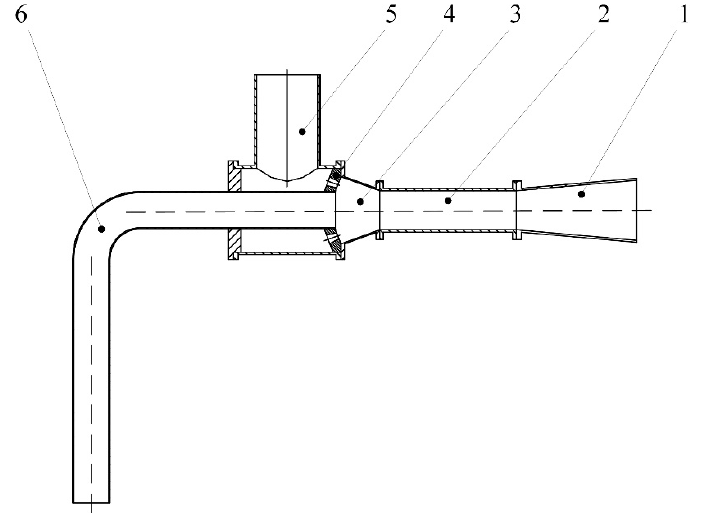
Figure 1. Structure of the annular multi-nozzle jet pump. 1: Diffuser; 2: Throat 3: Suction chamber 4: Annular multi-nozzle 5: Working fluid inlet 6: Suction pipe.